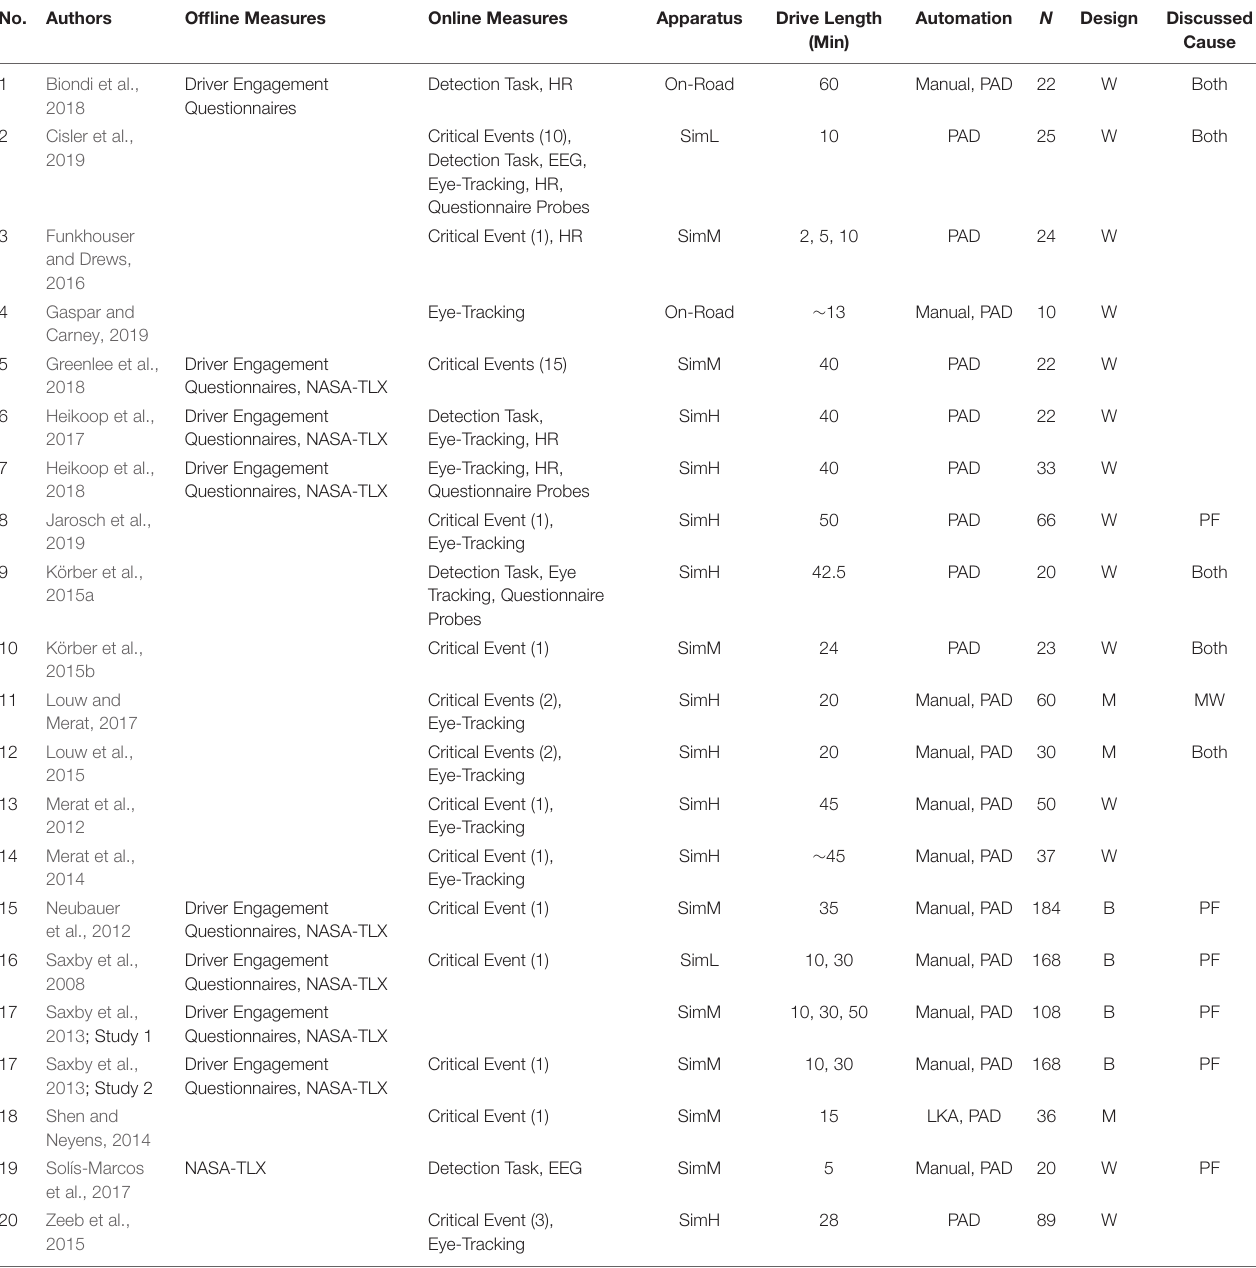
TABLE 2 | Table of papers that investigate driver vigilance during